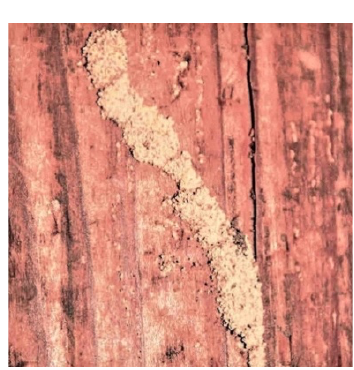
Figure 6 . Timber attacked by